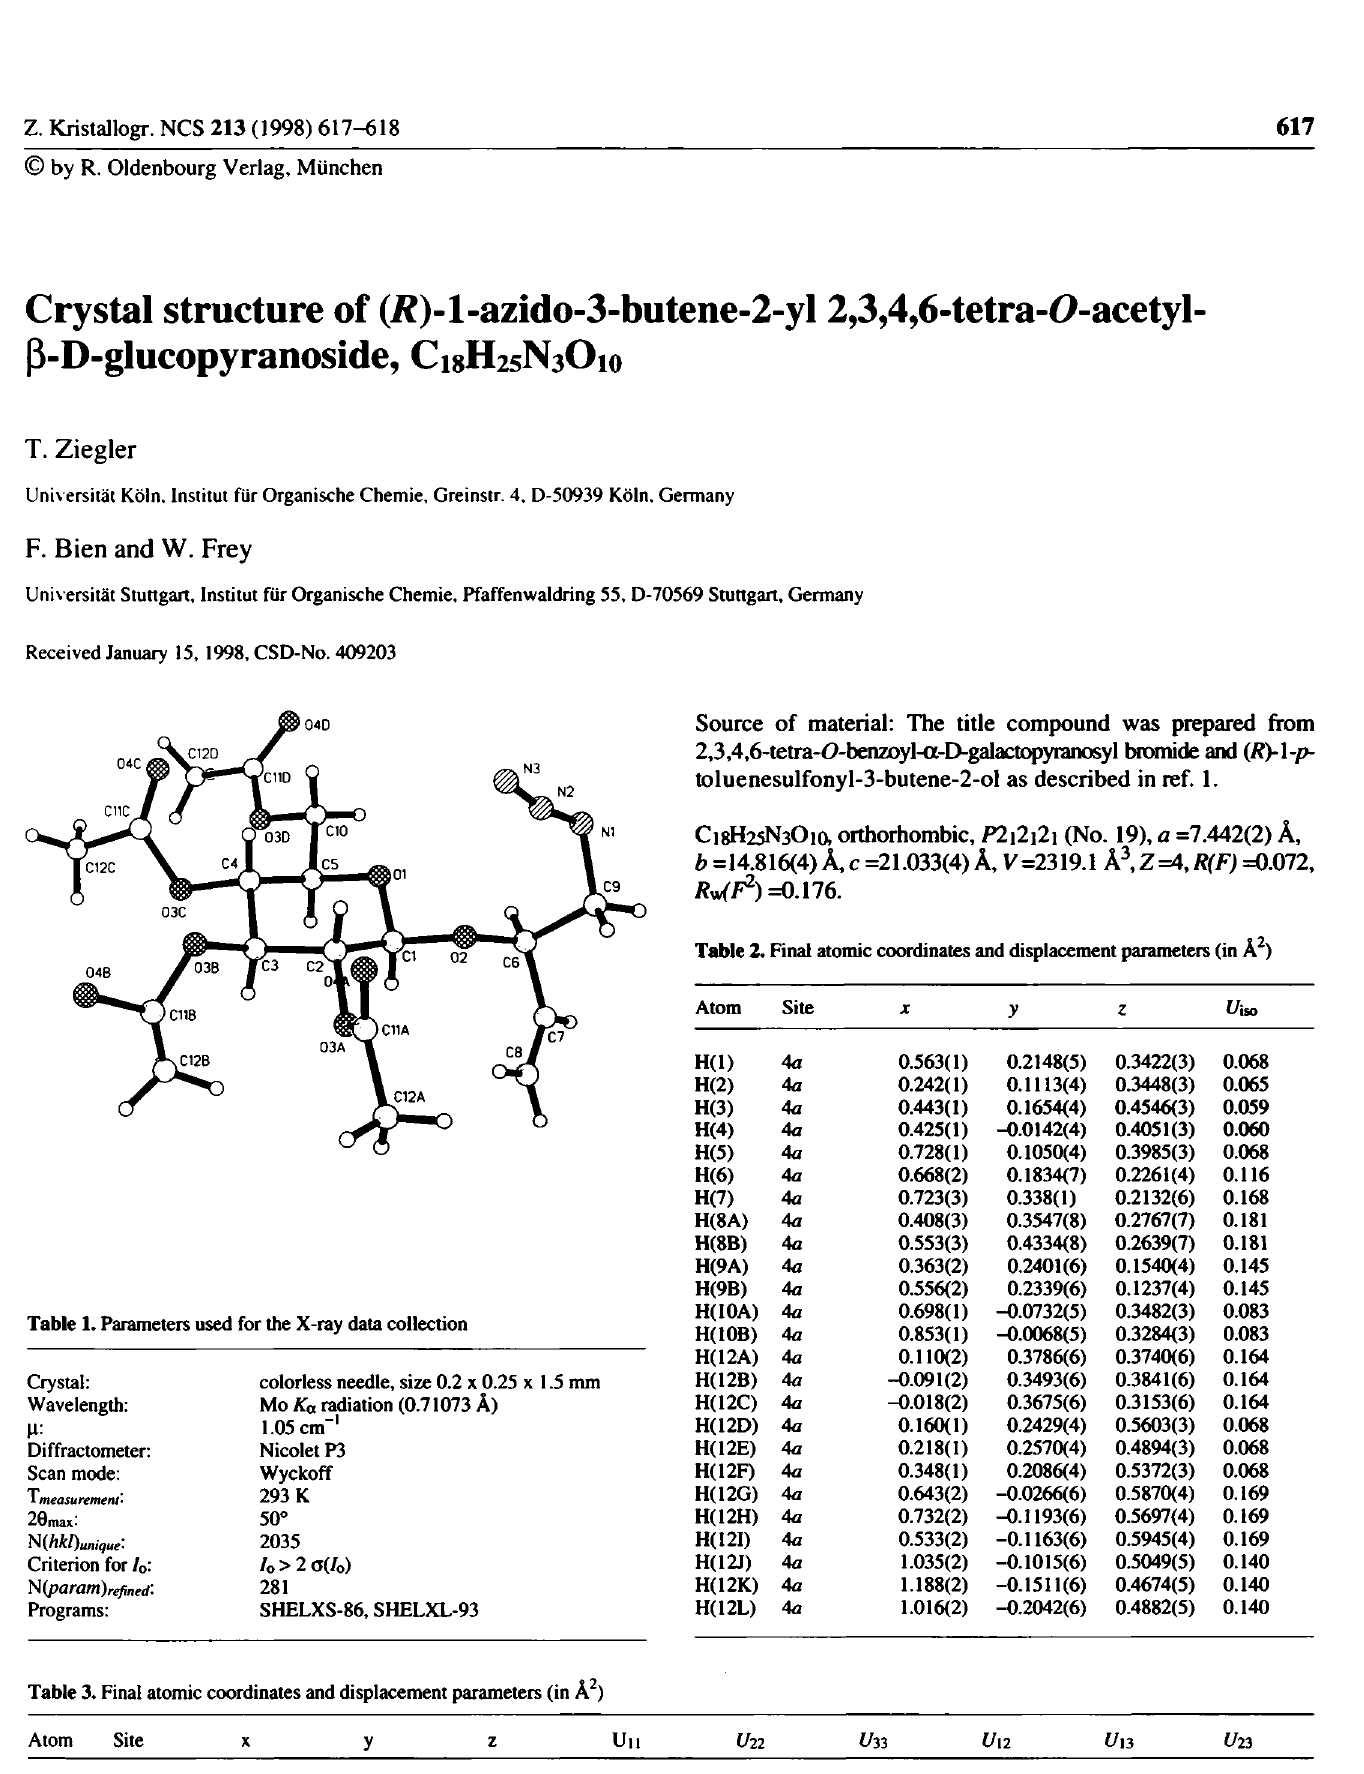
Table 3. Final atomic coordinates and displacement parameters (in